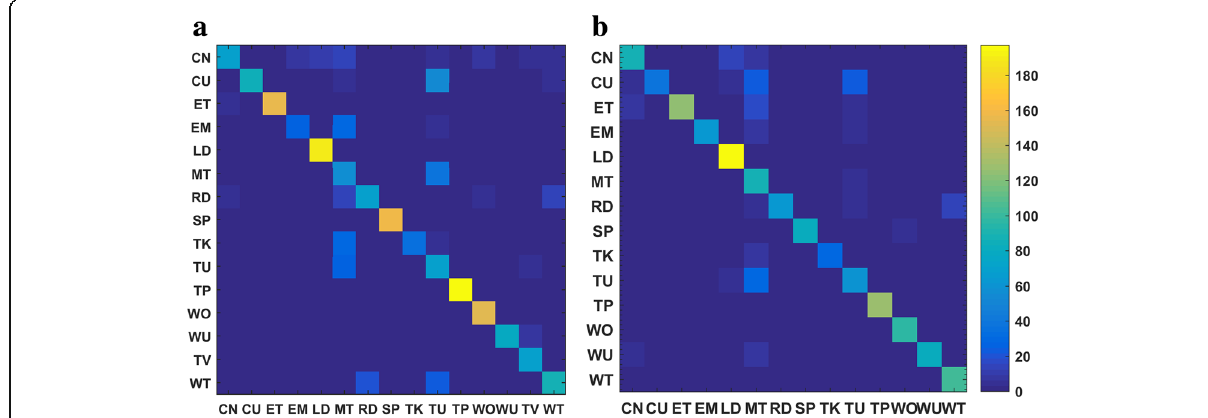
Fig. 7 Confusion matrices for the image-based method as applied to a wearer 1 and b wearer 2